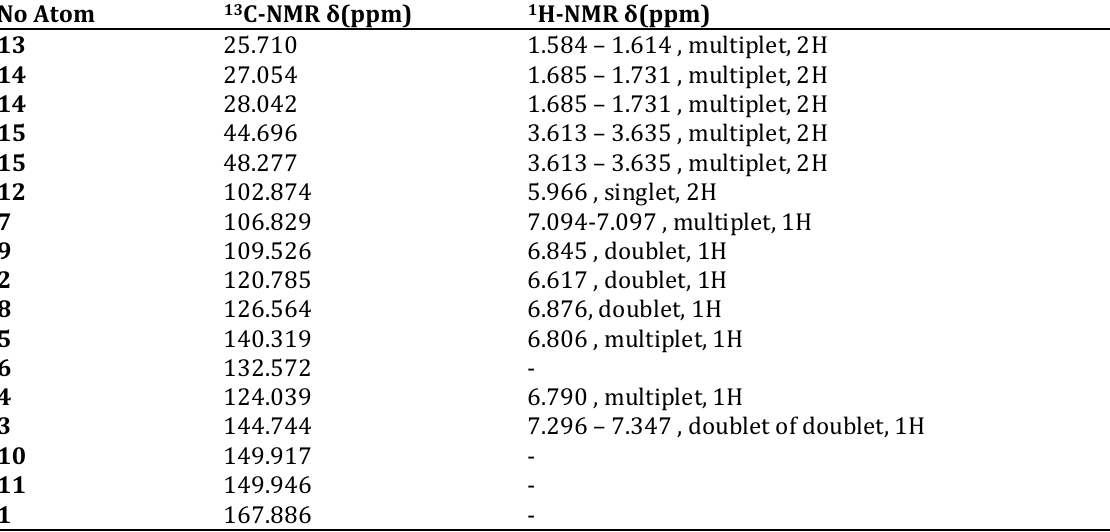
Figure 7. 13 C-NMR spectrum of isolated piperine Figure 8. 1 H-NMR spectrum of isolated piperine Table II. 13 C-NMR and 1 H-NMR spectra of the isolated piperine No